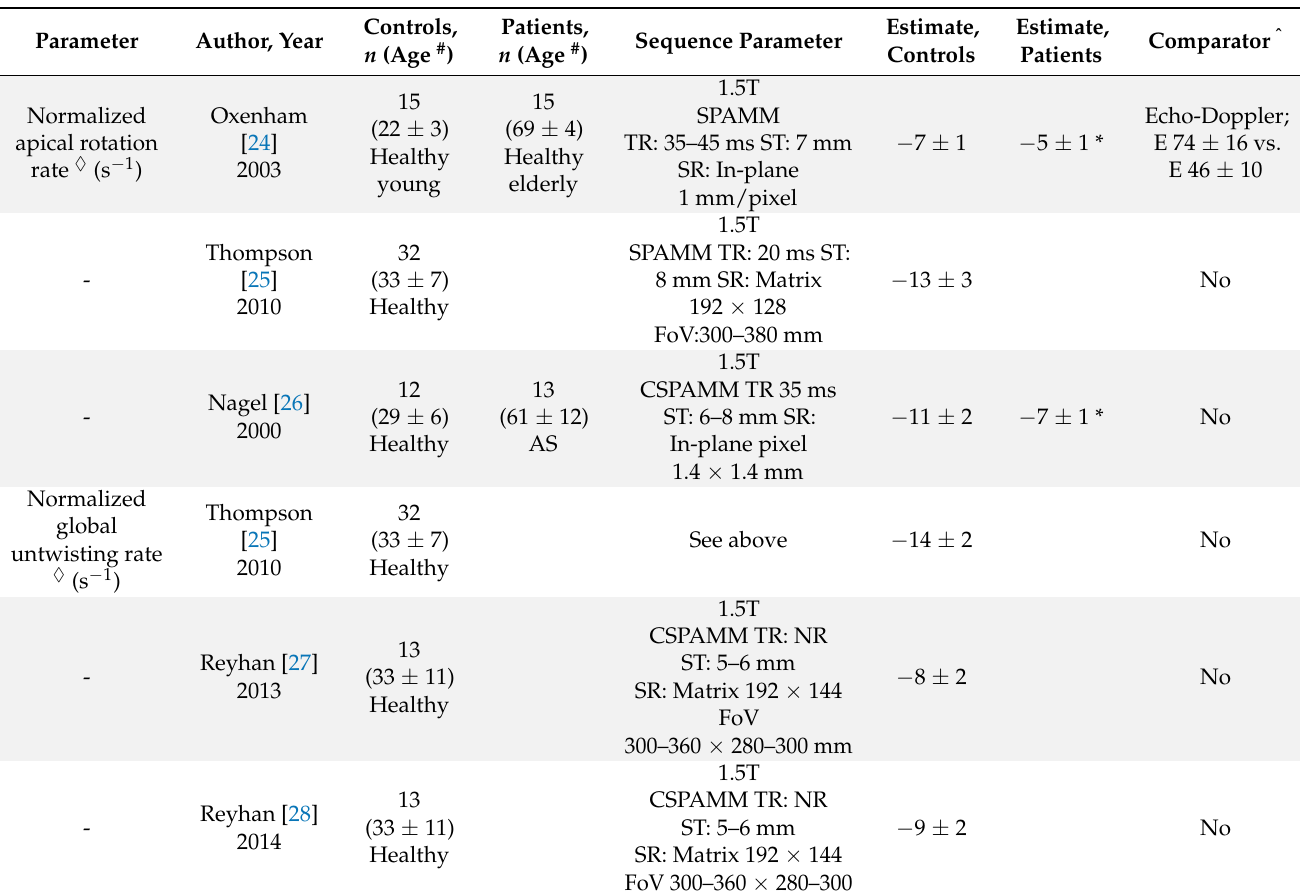
Table 1. CMR tagging—diastolic rotation and untwisting rates.